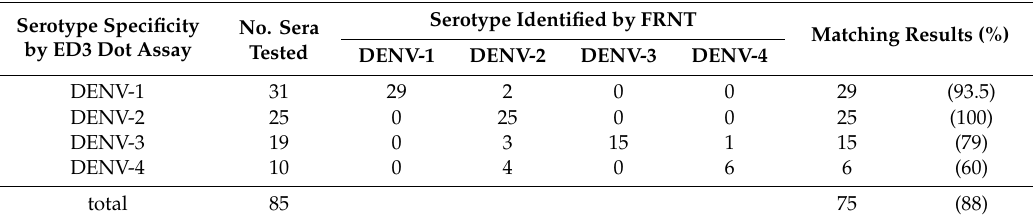
Table 1. Comparison of test results between ED3 dot assay and Foci Reduction Neutralization Test (FRNT).